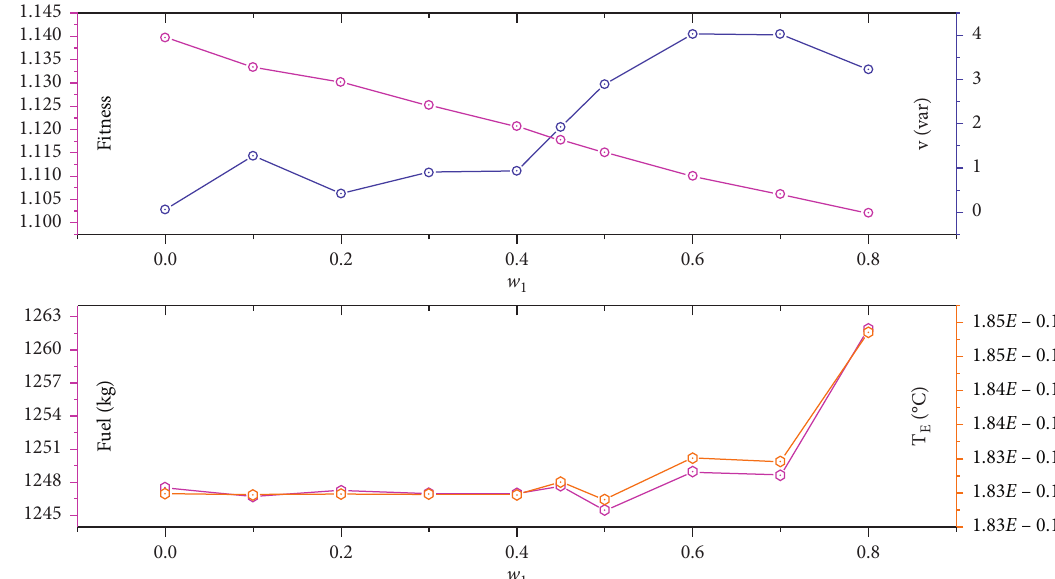
Figure 8: The impact of w